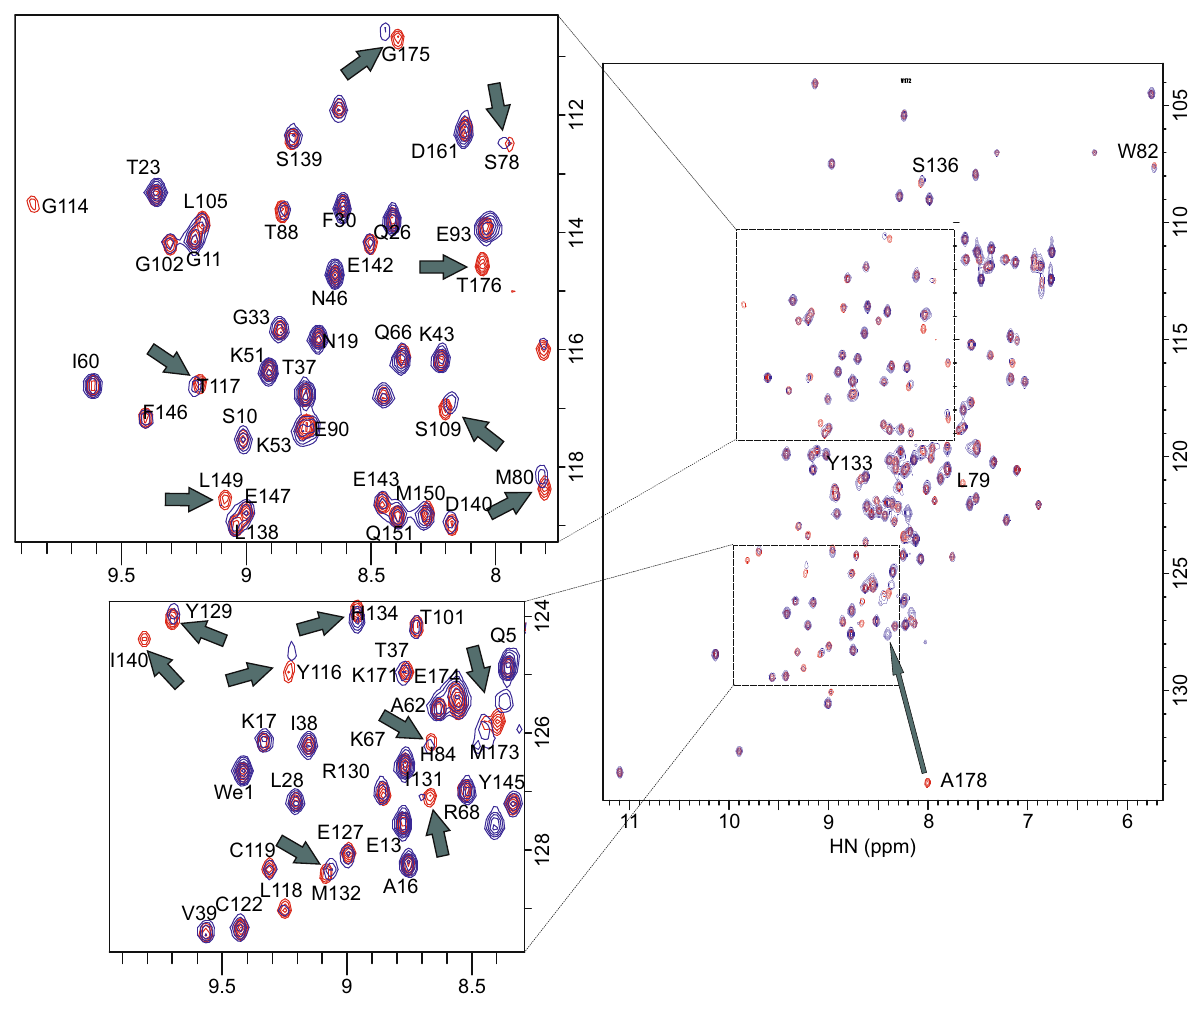
Figure 1. Structure perturbation of Csk identi fi ed by 1 H- 15 N-HSQC spectra . Overlay of 1 H- 15 N-HSQC spectra of the Csk SH32 with and without ligated kinase. Red: Csk [ 15 N] SH32; Blue: [ 15 N] SH32 ligated with unlabeled-kinase. Both of the two samples are concentrated to 0.1 mmol/L and complexed with 1 mmol/L 3BP1. The peaks indicated by arrows show signi fi cant chemical shift A178 (SH2-kinase linker) regions, are all spatially close to the N-lobe of kinase domain (Fig. 2C) in the full-length Csk crystal structure. The observed shifts indicate that some structural changes in this region accompany the ligation of the kinase domain.